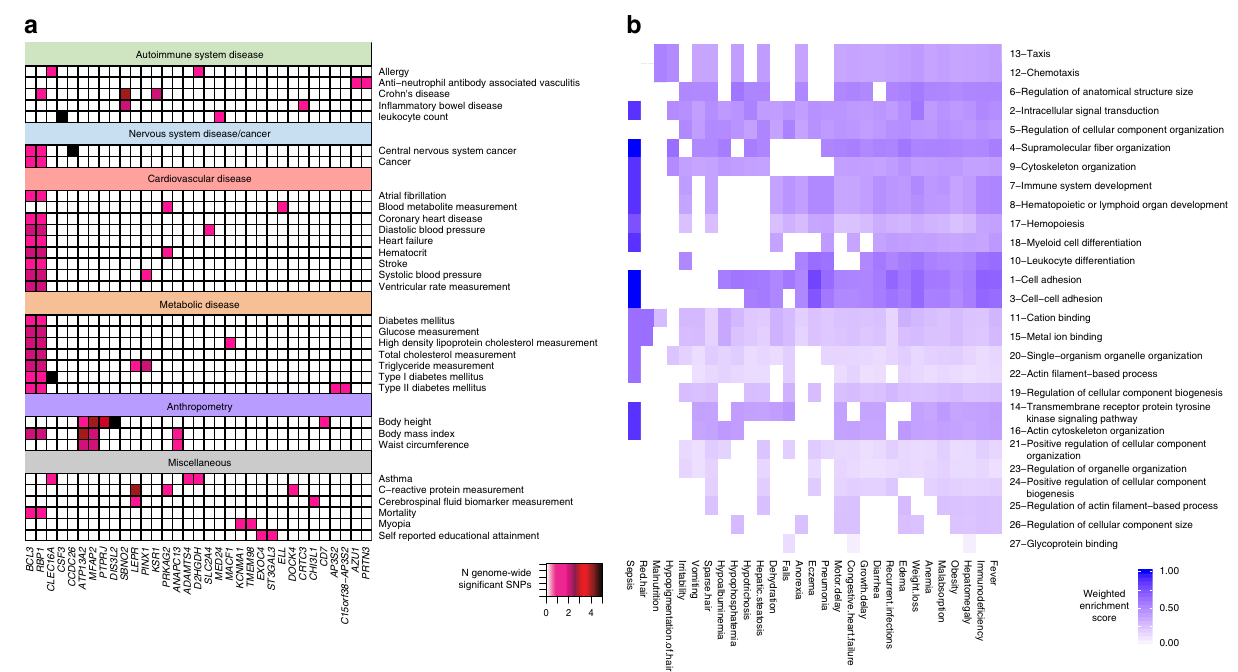
Fig. 4 Disease gene enrichment in ESAM. a Experimental Factor Ontologies (EFOs) from the GWAS catalog (Methods) with two or more genes represented among ESAM differentially methylated clusters (DMCs) are shown on the vertical axis and grouped according to their shared parent EFOs. The overlap between disease and gene is indicated by a shaded box. The color key associated with each box represents the number of genome-wide signi fi cant SNPs for each gene for the listed EFO. b Weighted enrichment values for gene ontologies enriched by study DMCs (SGOs; vertical axis) and phenotypes associated with kwashiorkor (KGOs; horizontal axis) in the Human Phenotype ontology (HPO). SGOs that are not found in the KGO list receive a value of 0 by default, and SGOs that are found in the KGO list and in the top quartile of both lists would have a value of 1. Ranking of SGOs is indicated in descending order by the number in front of the SGO term and was based on their aggregate weighted enrichment